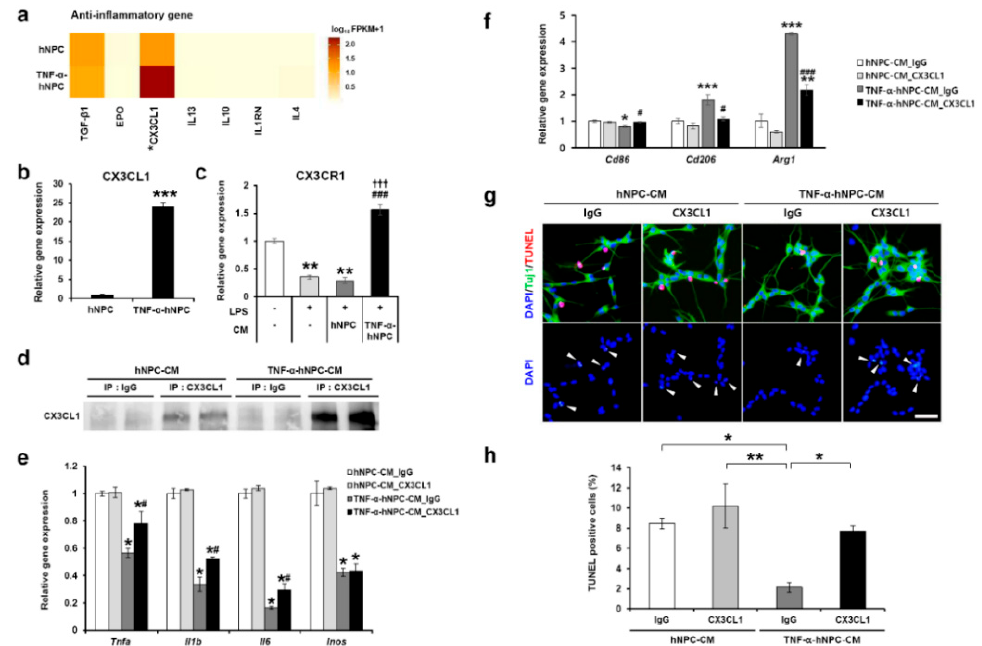
Figure 7. TNF- α -induced CX3CL1 affected microglia polarization and prevented neuronal damage in neuron-activated microglia co-cultures. ( a ) Heatmap of RNA-seq data analysis of transcripts encoding genes associated with inflammatory biological pathways. The heatmap was generated using the cummeRbund R package and converted to log10 FPKM values. An asterisk in heatmaps denotes CX3CL1 gene discussed in the text. ( b ) qRT-PCR analysis of CX3CL1, with significantly increased expression by TNF- α treatment in hNPCs. *** p < 0.001. ( c ) qRT-PCR analysis of CX3CR1 in BV2 cells. ** p < 0.01 vs. Media only; ### p < 0.001 vs. LPS/Media; ††† p < 0.001 vs. hNPC-CM. ( d ) CM from hNPCs or TNF- α -hNPC was depleted with 5 μ g/mL of monoclonal anti-rabbit CX3CL1 antibody or rabbit IgG. The CM treated with anti-CX3CL1 or normal IgG were immunoblotted with anti-CX3CL1. ( e ) Depletion of CX3CL1 in TNF- α -hNPC-CM significantly inhibited the decrease of pro-inflammatory genes compared with depletion of IgG in TNF- α -hNPC-CM, as quantified by qRT-PCR. f qRT-PCR was performed to quantify the mRNA expression of CD86, CD206, and Arg1 in BV2 cells. ( e , f ) * p < 0.05, ** p < 0.01, and *** p < 0.001 vs. hNPC-CM-IgG; # p < 0.05, ### p < 0.001 vs. TNF- α -hNPC-CM-IgG. ( g ) Cell-specific markers and separate nuclear stain were combined with a TUNEL assay. TUNEL: TMR red (red), neuron-specific marker: Tuj1 (green), nucleus-specific marker: DAPI (blue). Total cell numbers per field were established by counting individual nuclei (blue). The nuclei indicated by arrows (lower panel) overlap with TUNEL+ apoptotic cells (upper panel). Scale bars, 25 μ m. ( h ) Quantitative analysis of the TUNEL assay. TUNEL-positive cells were counted in four images of randomly chosen fields per group, and at least 100 cells were counted per field. Data are presented as the means ± SEM from three independent experiments performed in triplicate. * p < 0.05 and ** p < 0.01.